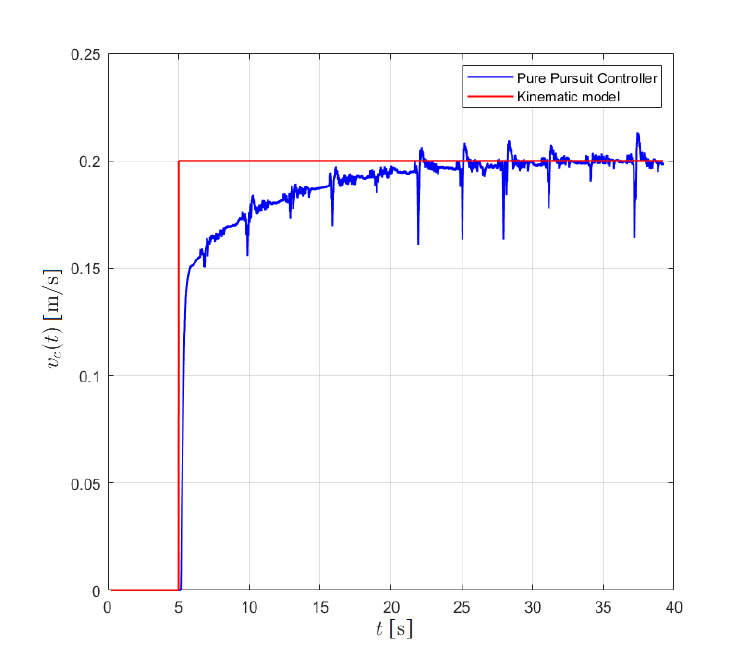
Figure 10. Linear velocity v c ( t ) of the